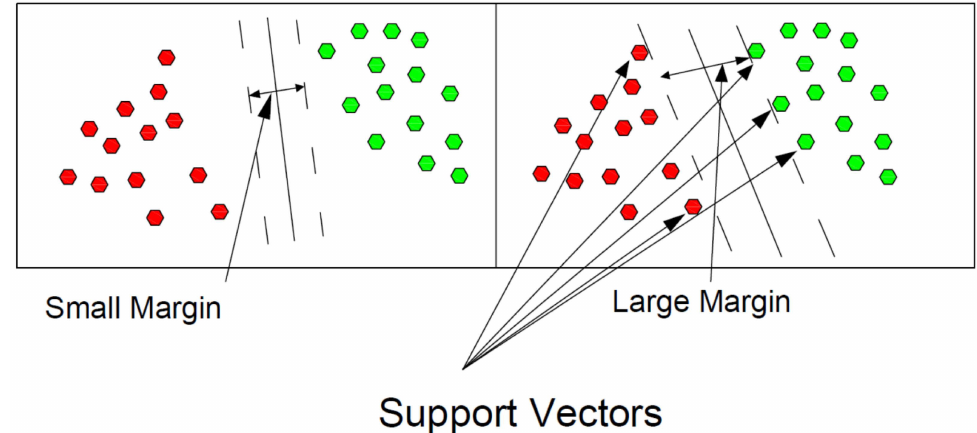
Figure 2. SVM algorithm indicates the margin separating two